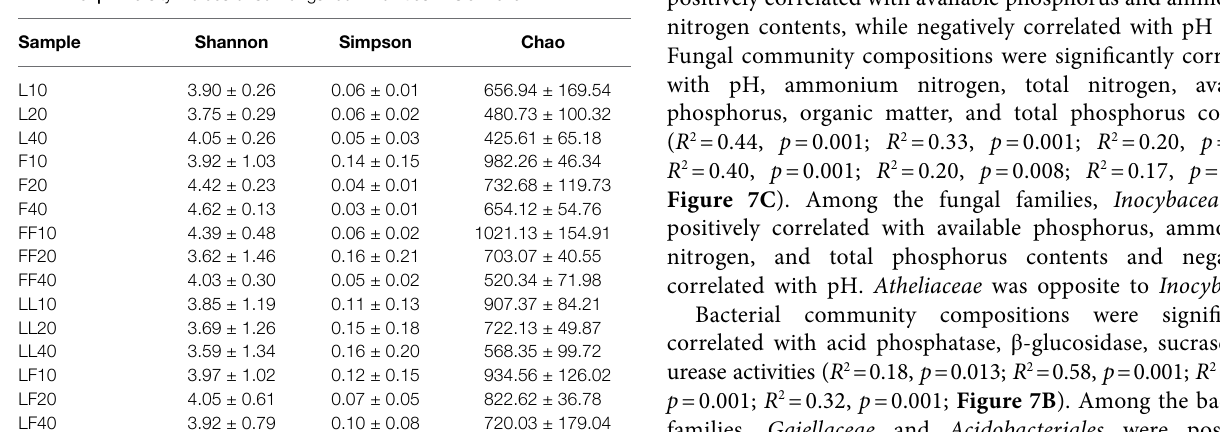
TABLE 3 | Diversity indices of soil fungal communities in OUT